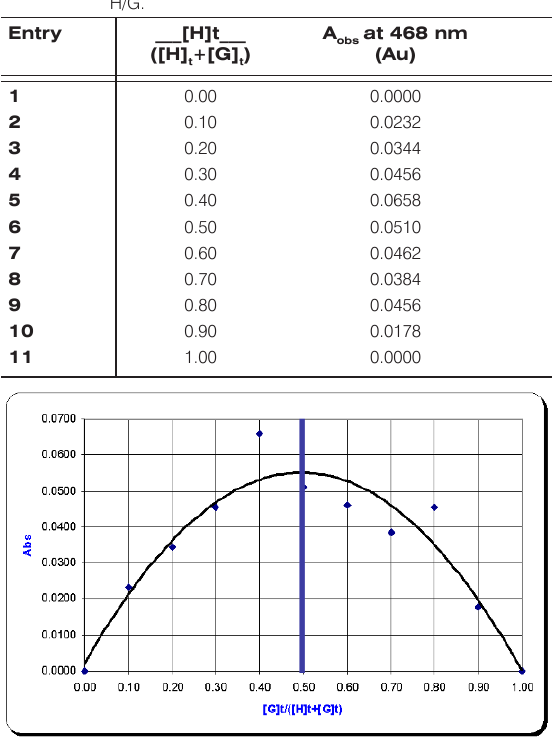
Table 3. Absorbance of the complex measured for different ratio